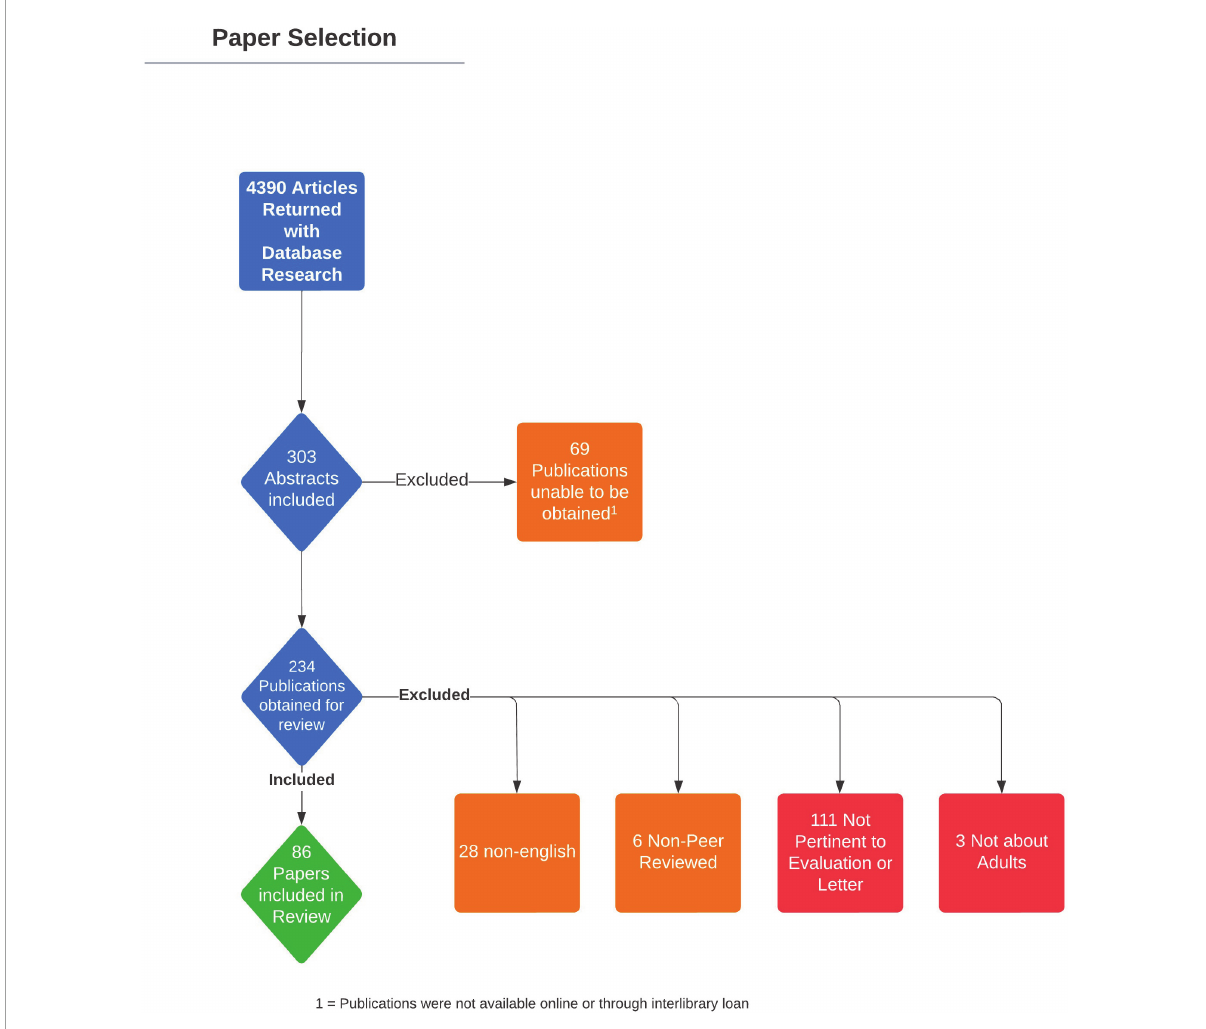
FIGURE1 PRISMA flow diagram demonstrating article review